Question: Generate an informative caption for the figure above.
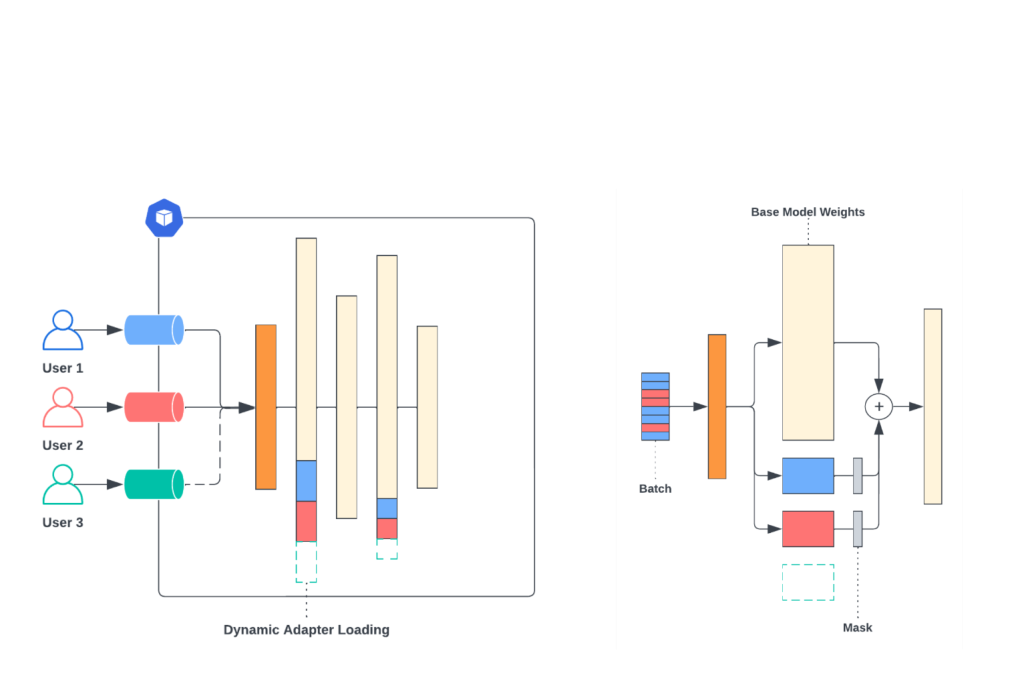
Answer: Dynamic adapter loading (left) enables multiple concurrent fine-tuned models to process requests. User 3’s model (green) is loaded in the background while the other requests proceed as usual. Continuous Multi-Adapter Batching (right): Multiple adapters are decoded in a single batch. Masks ensure that only the right adapter is used for processing each element of the batch.